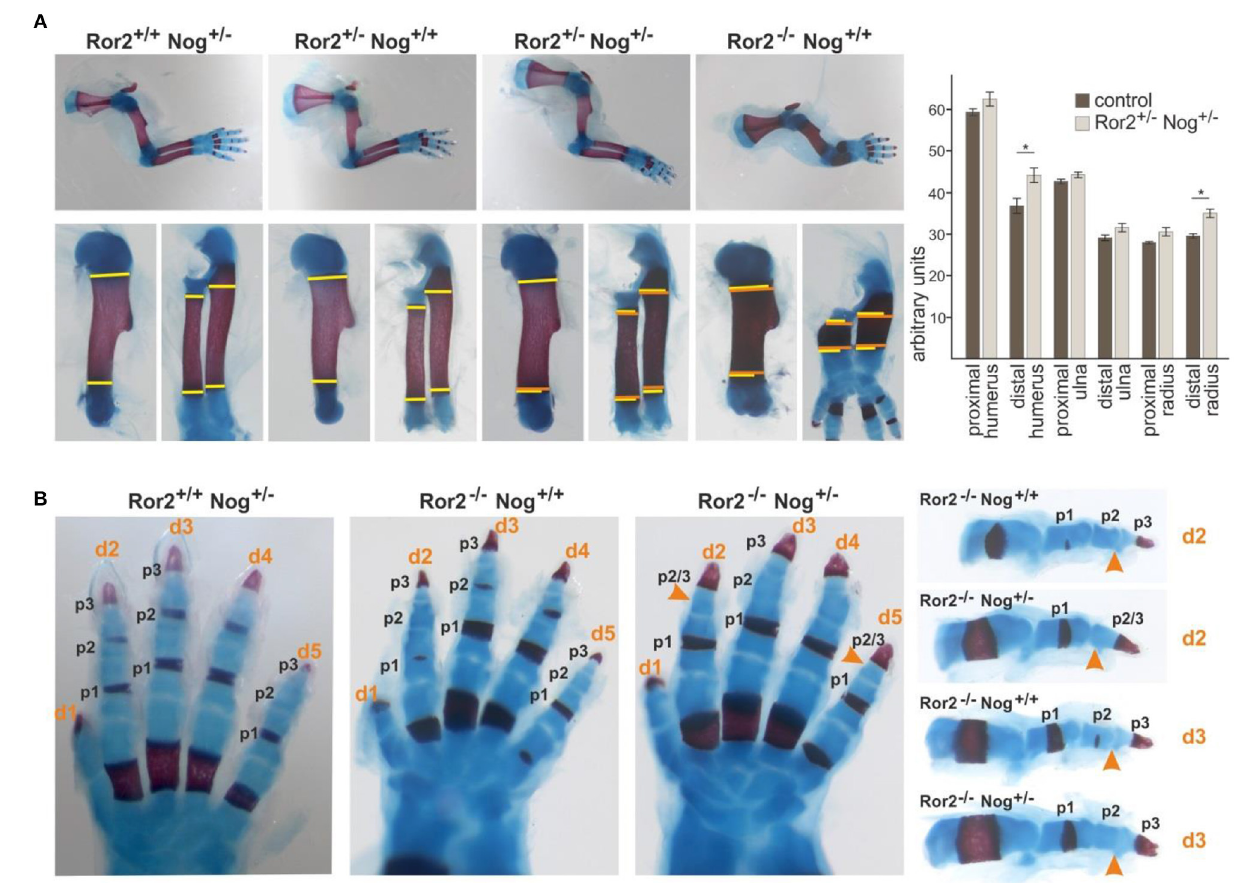
FIGURE 1 | Noggin genetically interacts with Ror2. Skeletal preparations of E18.5 embryos of the indicated allelic combinations are shown. Cartilage stains blue, bone stains red. (A) Top panel: Limbs of compound Ror2 and Noggin heterozygous mutants have a normal appearance. Ror2 − / − skeletal elements are visibly shortened and enlarged. Bottom panel: magnifications of humerus and radius/ulna. The width of the wild type or single heterozygous skeletal elements is indicated by a yellow line on either side of the ossification center. Width of the double heterozygous or Ror2 − / − skeletal elements is indicated by orange line for comparison. A quantification of skeletal element width is shown right; significant effects were observed for the distal humerus and distal radius ( p < 0,05; student’s t -test). (B) Digit development in compound mutants. Ror2 − / − digits are shortened, but individual phalanges (p1, p2, and p3) are present, separated by synovial joints. In Ror2 − / − ;Nog + / − animals, the medial phalange (p2) shows additional shortening, which in digits 2 and 5 leads to distal symphalangism of p2 and